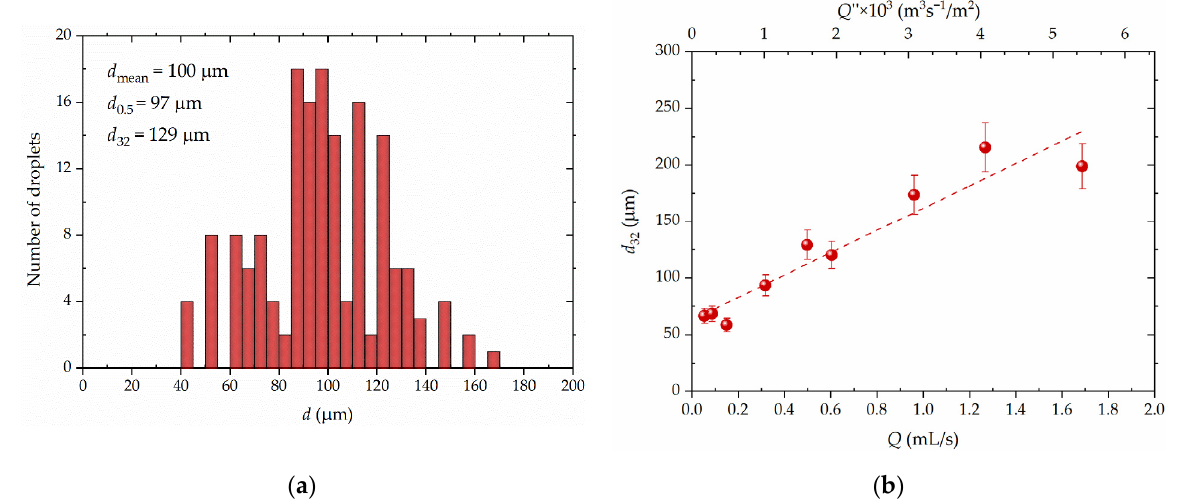
Figure 5. ( a ) Droplet size distribution during spray irrigation ( Q = 0.5 mL/s); ( b ) Sauter mean diameter dependence on the flow rate.